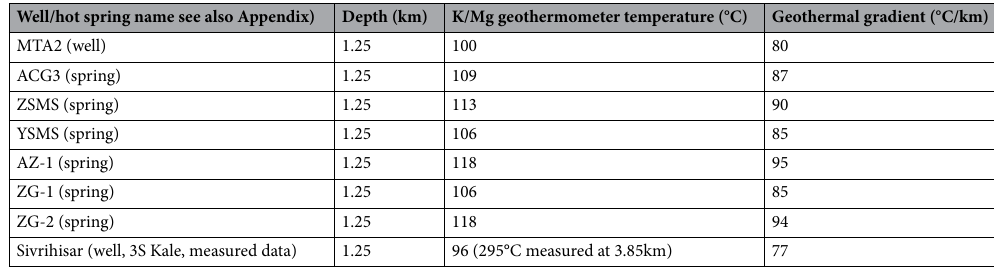
Table 1. Measured and estimated geothermal gradient in the study area using well data and K/Mg geothermometry.